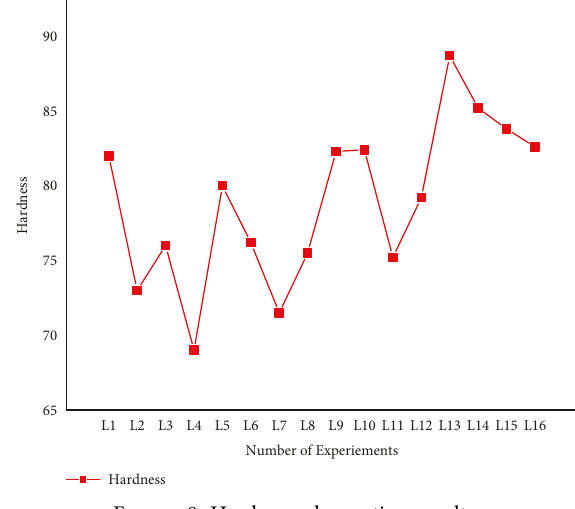
Figure 8: Hardness observation results.